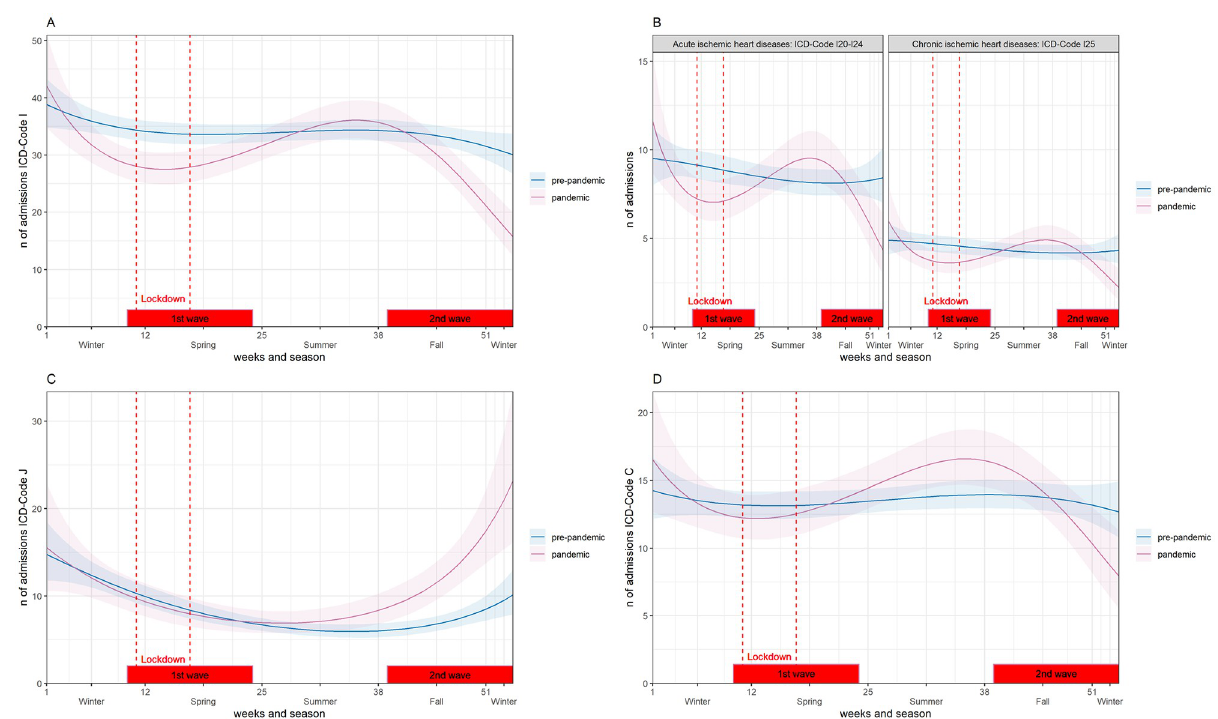
Fig 4. Weekly changes in admissions by diagnosis from 2017–2019 (pre-pandemic period) and 2020 (pandemic period). Negative binomial regression model of the number of admissions by International Classification of Diseases–10 th (ICD) code. (A) Circulatory system ICD-Code I. (B) Ischemic heart diseases ICD-Codes I20-24 and I25. (C) Respiratory system ICD-Code J. (D) Neoplasm ICD-Code C. 1st Wave: calendar weeks (10–24); 2nd Wave: calendar weeks (39–53). Lockdown: March 17—April